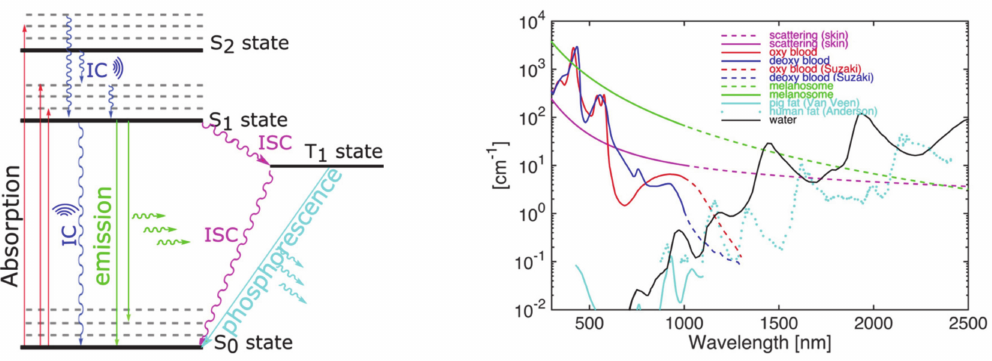
Figure 2. Left: A Jablonski diagram shows the photoexcitation of electrons into various molecular orbital levels, which is causal for the absorption spectrum of dyes. The excited chromophore can be deactivated by multiple pathways including photoacoustic (PA) generation through the internal conversion (IC) mechanism in which the absorbed light energy is converted into thermal energy; (ISC: inter system crossing; indicating a change in spin of the system). Right: The absorption spectra of various biological pigments in the visible to near-infrared (NIR)-I / II / III-region (Reproduced under from open source OMLC.org under https: // creativecommons.org / licenses / by / 4.0 /